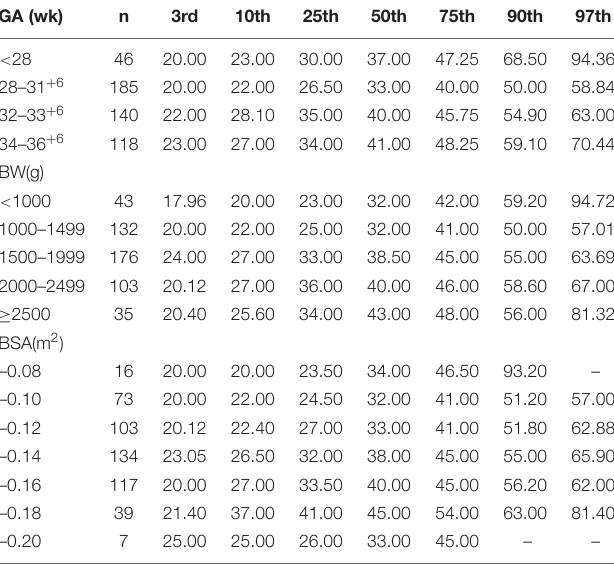
TABLE 10 | Doppler maximum velocities of MV-E (cm/s) (from 3rd to 97th centiles) in relation to GA, BW and BSA in preterm infants.